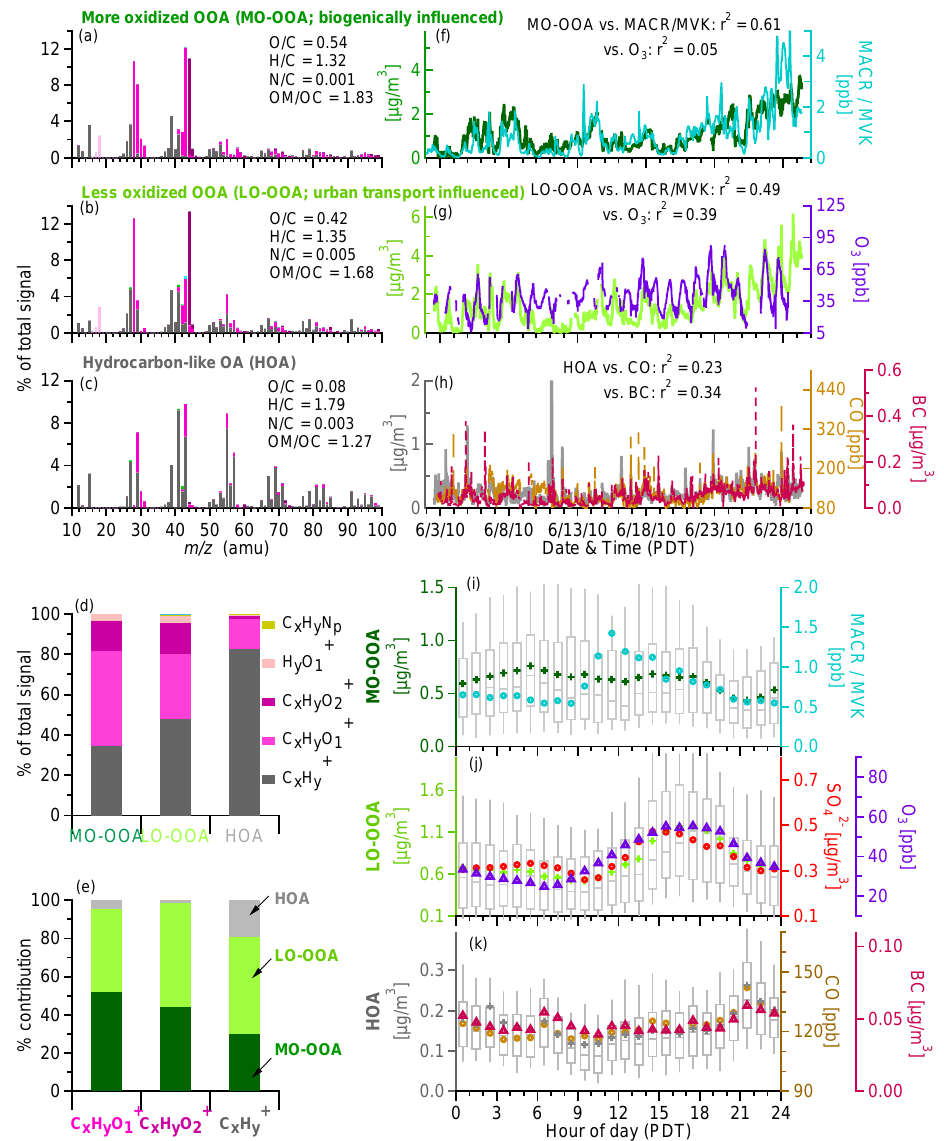
Fig. 11. High-resolution mass spectra (colored by ion category) and elemental ratios of the OA factors. Average contribution of ion categories to the total signal of the OA factors (d) , and average contribution of OA factors to the three main ion categories (e) . Time series (f, g, h) and diurnal patterns (i, j, k) of OA factors and tracer compounds, along with their correlation coefficients ( r 2 ). Grey box plots for OA factors (i, j, k) : whiskers correspond to the 10th and 90th percentile, boxes to the 25th and 75th percentile, the horizontal marks in the boxes to the median, and the colored solid circles to the mean. Colored markers for tracer compounds (i, j, k) correspond to the